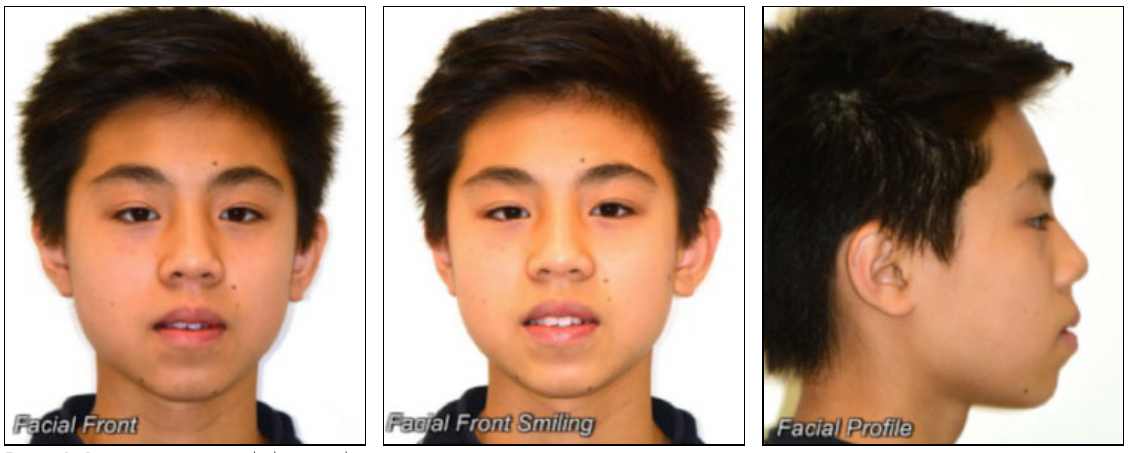
Figure 1. Pretreatment extra-oral photographs.